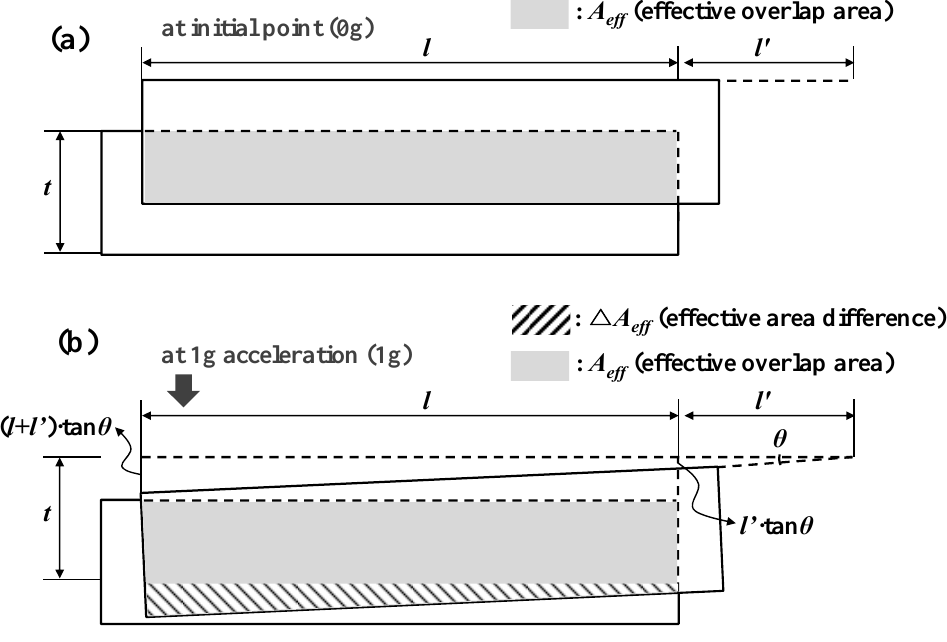
Figure 5. (a) Effective overlap area at zero input acceleration. (b) Effective overlap area and effective area difference at 1 g input acceleration. Cross-sectional diagram of interdigitated sensing comb